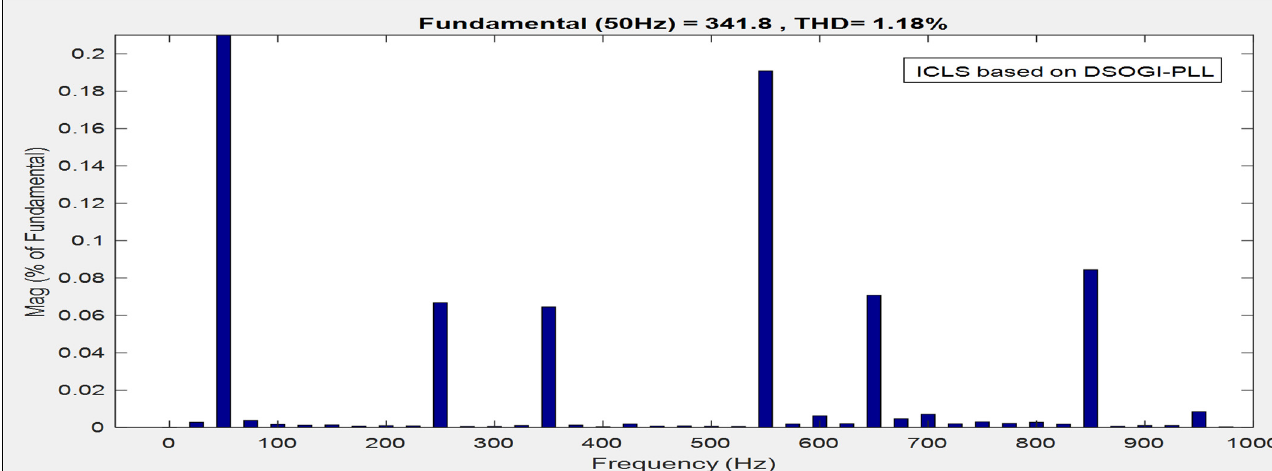
Figure 18. Case study 2 three-phase grid voltages and current with NRIT. Figure 19. The THD case study 2 performance results with NRIT.